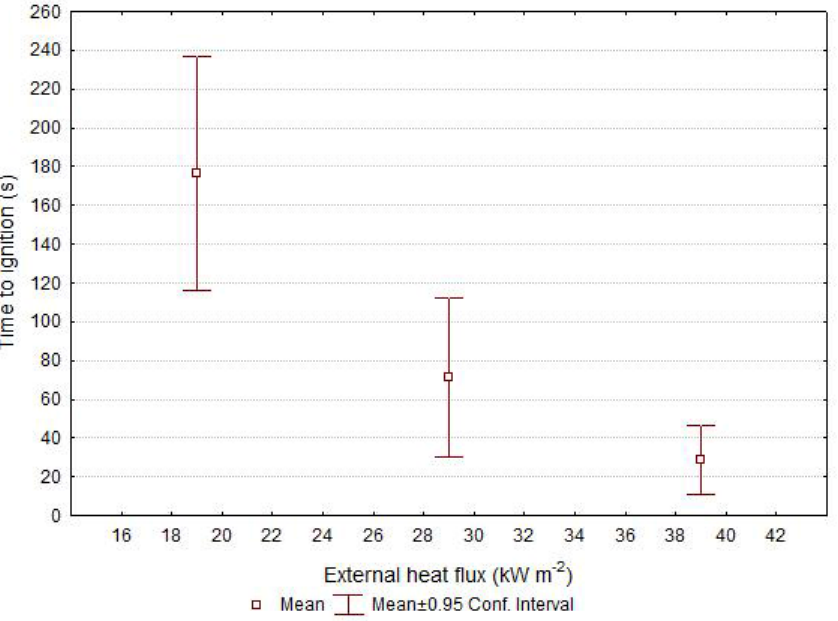
Figure 5. Impact of external heat flux on the time to ignition of torrefied wood.